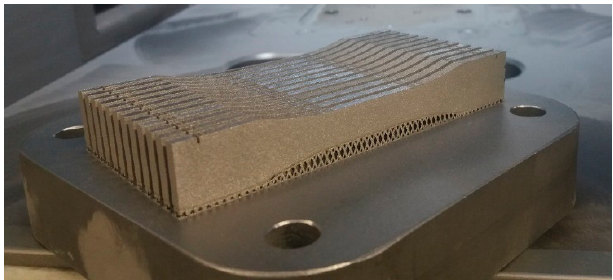
Figure 5. Tensile test samples on the selective laser melting (SLM) 125 HL machine building platform.